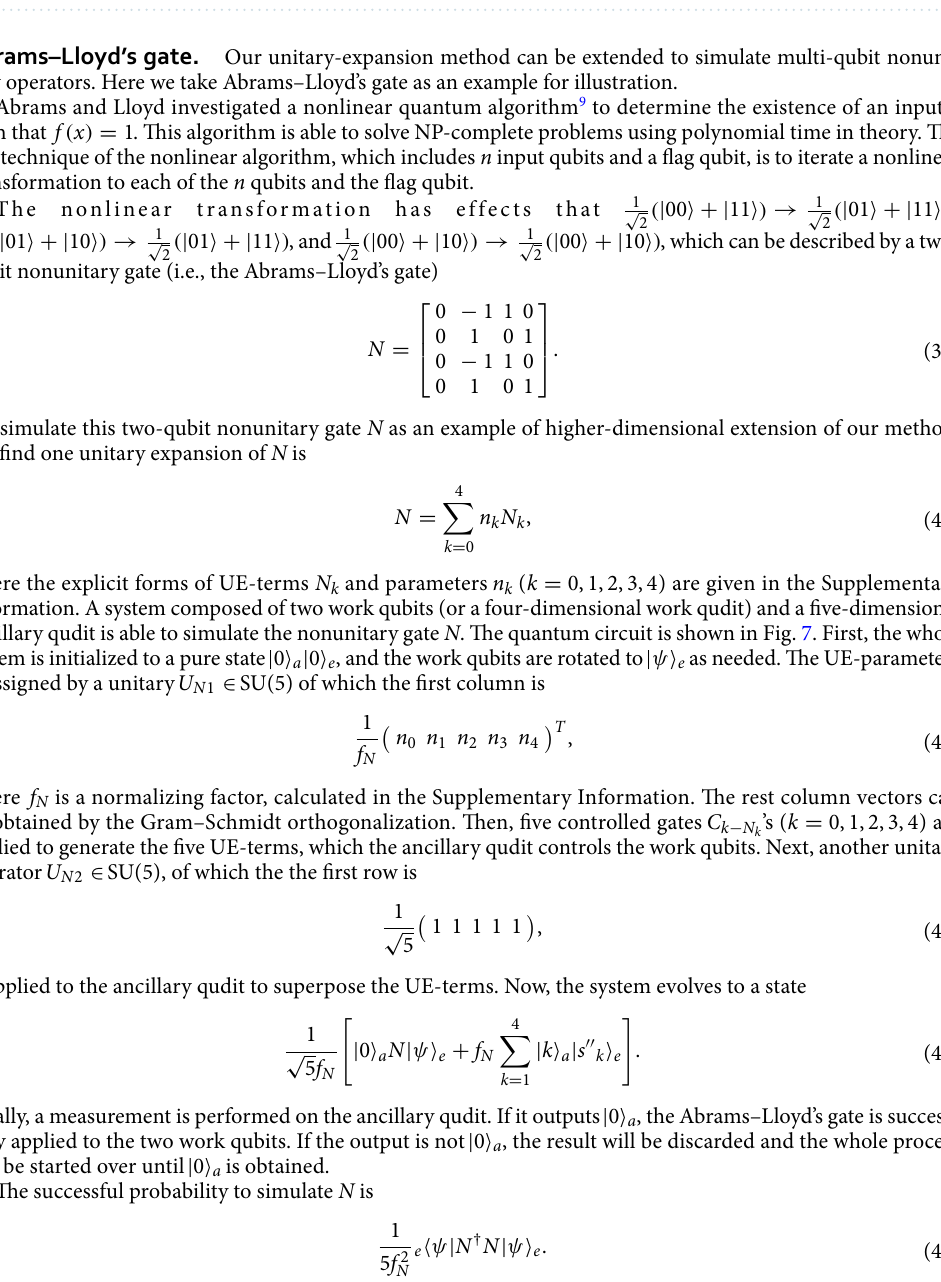
Figure 7. Quantum circuit to simulate Abrams–Lloyd’s gate. The system consists of a five-dimensional (5D) ancillary qudit and a four-dimensional (4D) work qudit (or two qubits), and is initialized to UE-parameters are assigned by U N 1 SU(5), and then five controlled operations generate the related five ∈ UE-terms N k ( k 0–4), which are superposed by U N 2 SU(5). Finally, a measurement is performed on the ∈ = ancillary qudit. If it